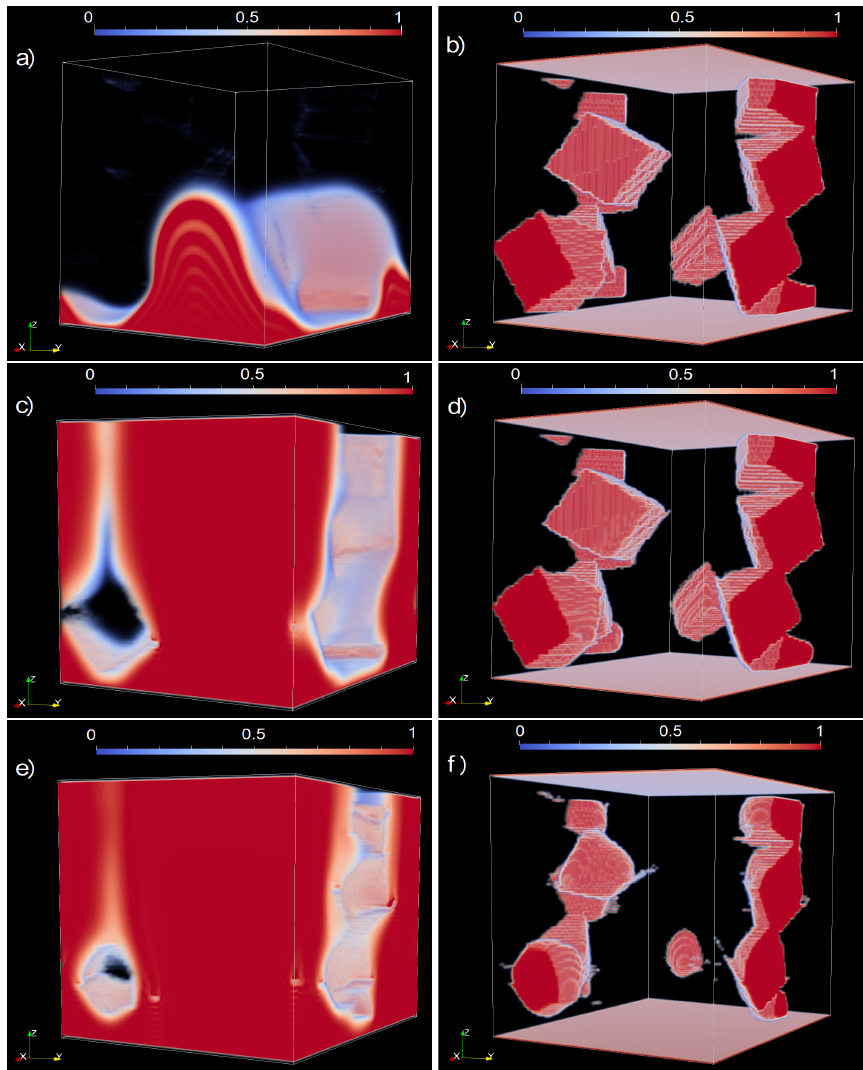
Figure 6. Solvent and mineral distributions at various stages during a large Peclet number (Pe = 1000) flow. ( a ) Solvent concentration at initial stages, ( b ) mineral content at initial stages, ( c ) solvent concentration at middle stages, ( d ) mineral content at middle stages, ( e ) solvent concentration at final stage, and ( f ) mineral content at final